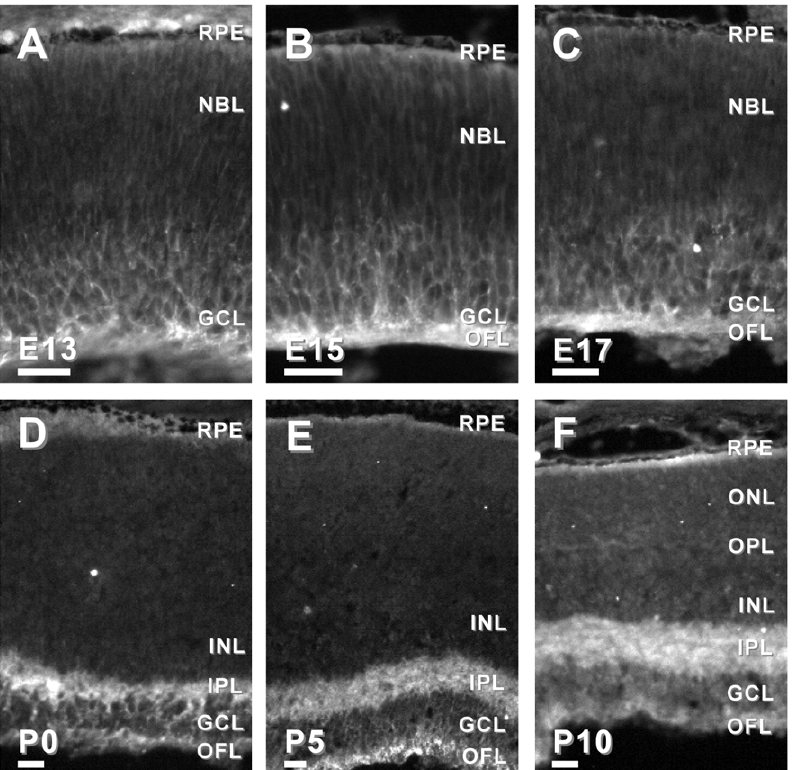
Figure 3. Dynamic protein expression of NDN in developing mouse retina. NDN-IR in the E13 mouse retina was localized to cells in the inner one-third of the retina (A). Similarly, in the E15 (B) and E17 (C) retinas NDN-IR was observed in the inner retina, including the GCL and OFL. In the P0 retina, NDN-IR was restricted to the developing IPL and OFL (D). Similarly, in the P5 and P10 retinas, NDN-IR remained in the IPL and OFL, respectively (E and F). Abbreviations same as in Figure 2. Bars, 30 m m.